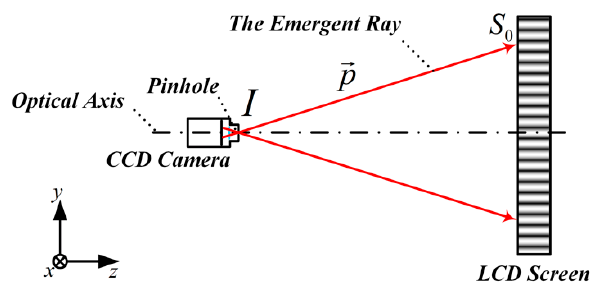
Figure 7. Ray sketch of the calibration strategy.